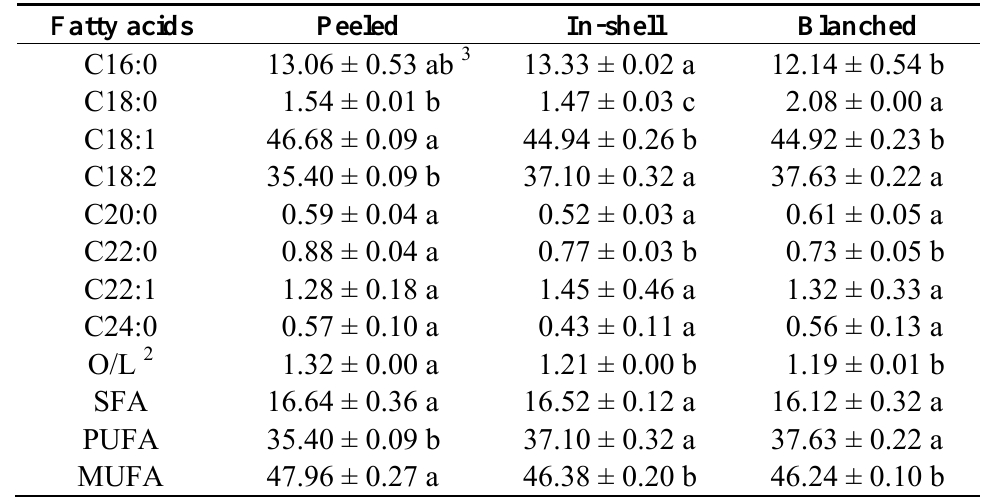
Table 2. Fatty acid compositions of the peanut samples (g/100 g) 1